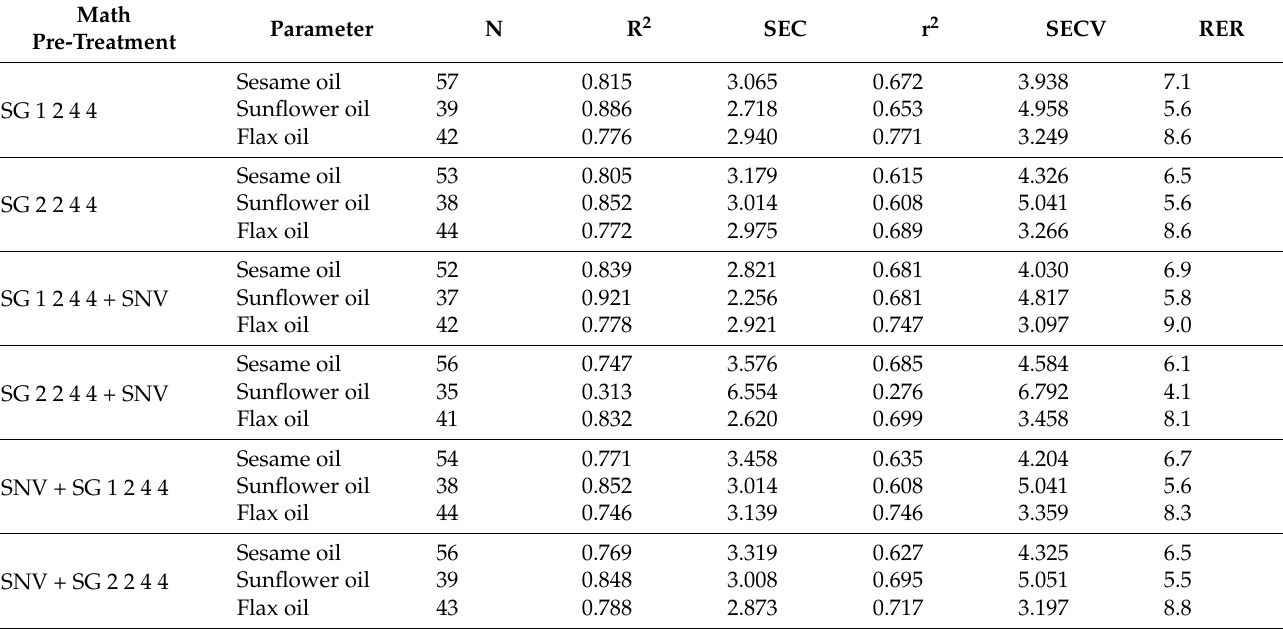
Table 3. Calibration and cross ‐ validation statistics of developed models to quantify adulteration of olive oil with seed oils (N = 96).